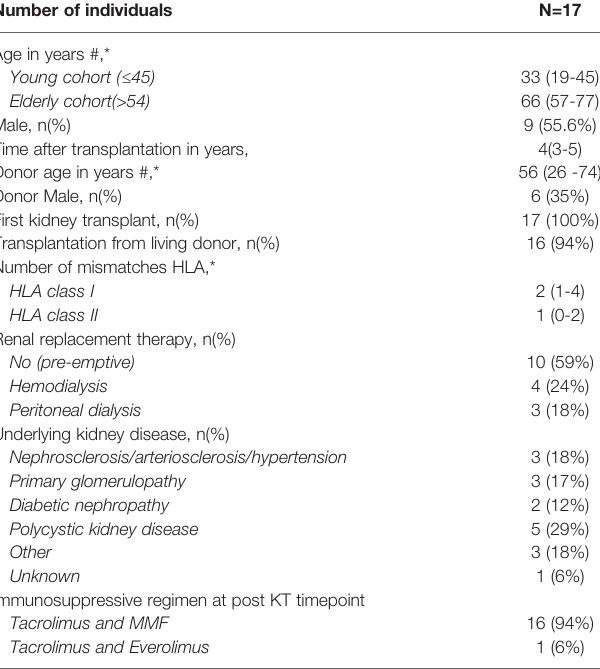
TABLE 1 | Study population